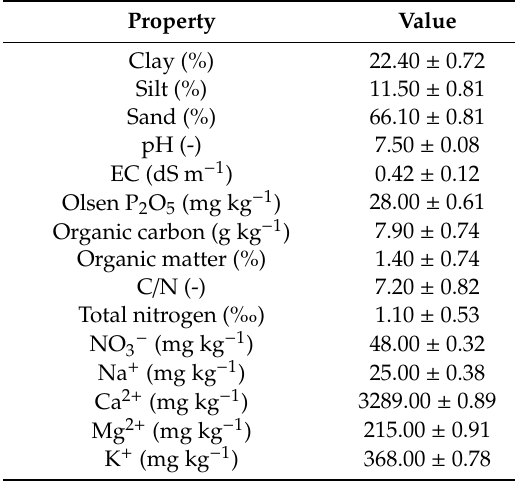
Table 1. Main physico-chemical properties of the soil utilized in the